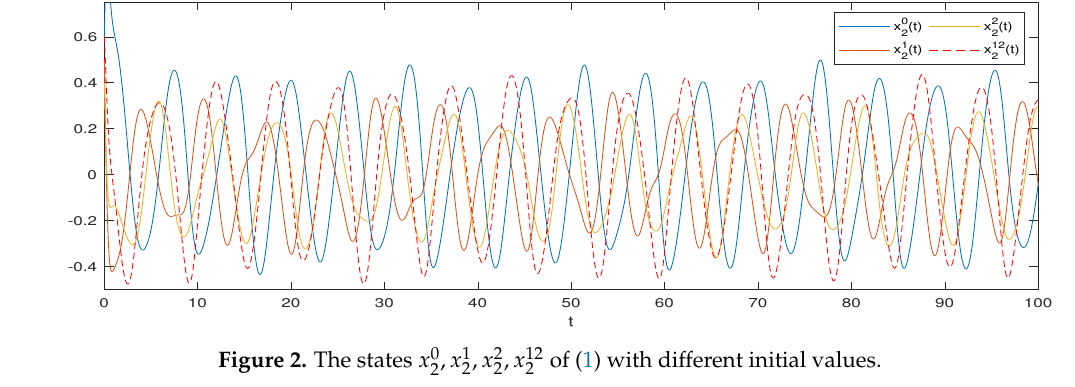
, x 1 , x 2 , x 12 of (1) with different initial values. 2 2 2 2